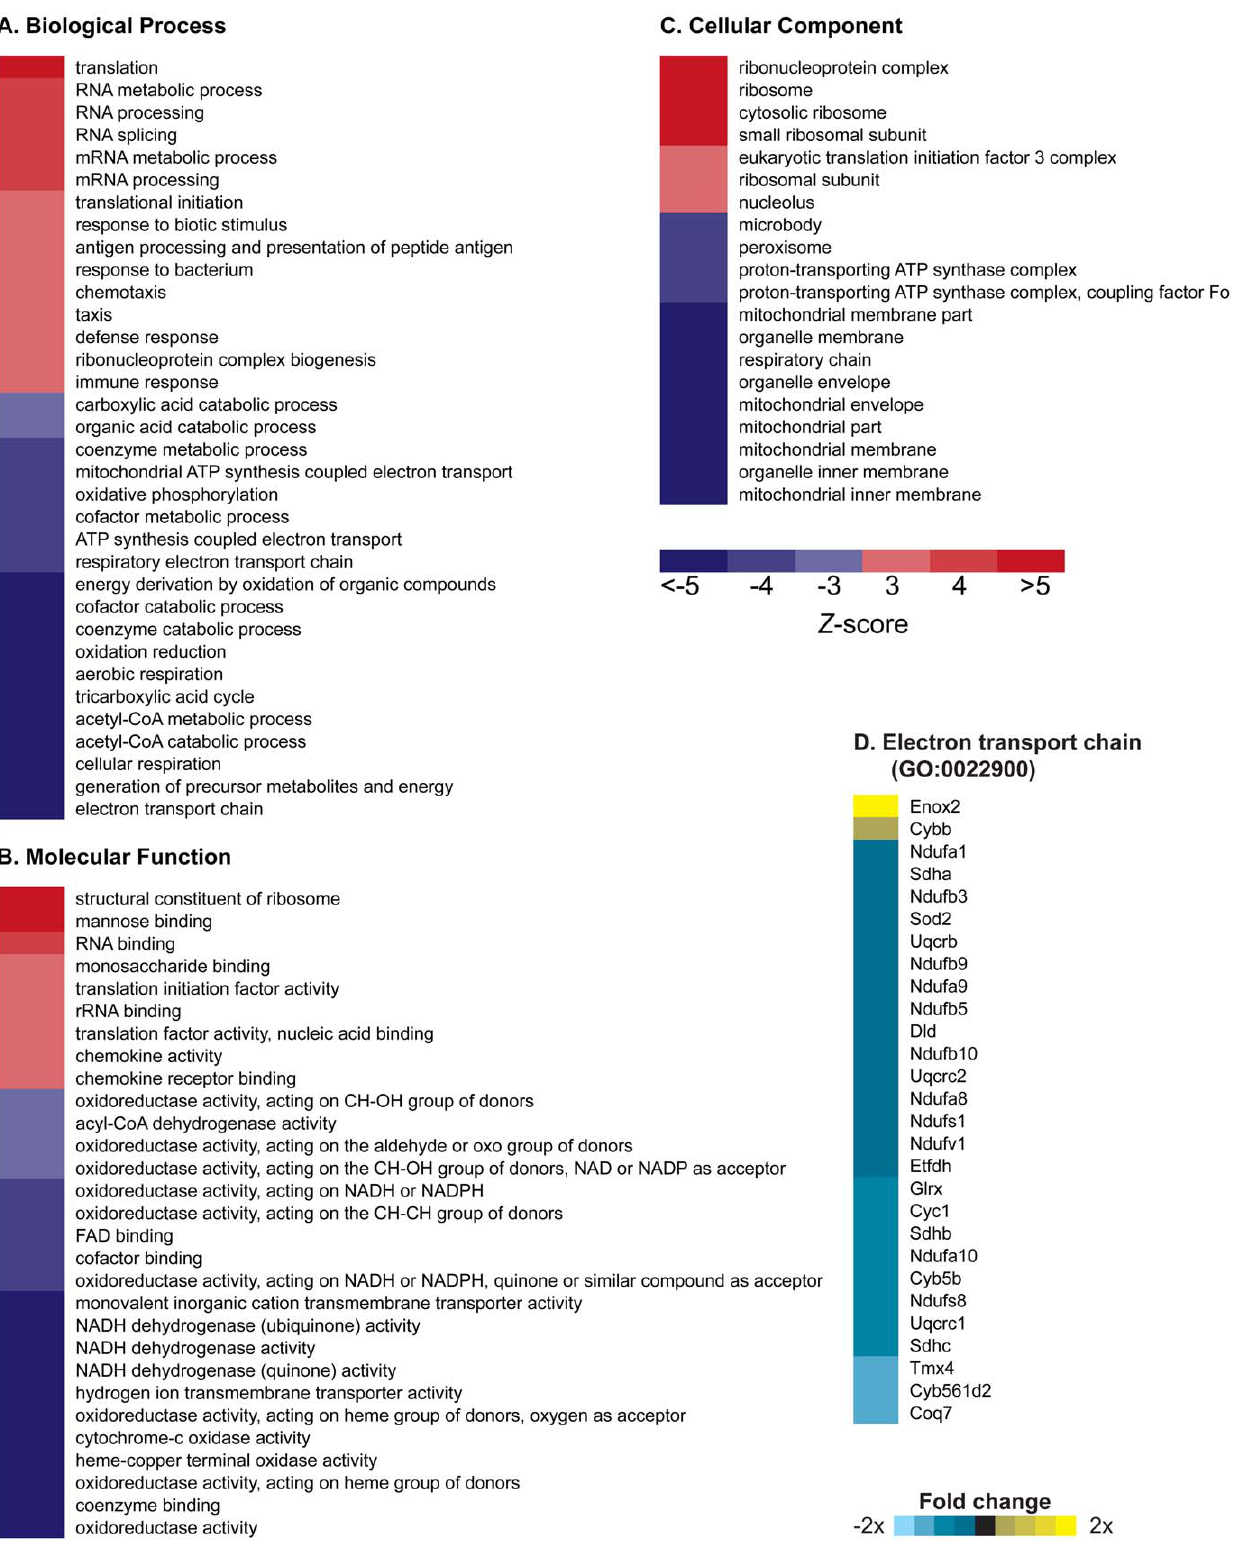
Figure 2. Parametric Analysis of Gene Set Enrichment identifies Gene Ontology (GO) terms changed in gastrocnemius muscle of 13- month old D257A mice as compared to 13-month old WT mice. (A, B, C) Terms shown are those significantly changed ( p , 0.01, FDR , 0.01). Red indicates a GO term that was induced by mtDNA mutations ( Z -score . 0); blue indicates GO terms that were suppressed by mtDNA mutations ( Z - score , 0). n=5 mice per group. (D) Genes listed within the GO term ‘‘electron transport chain’’ ( Z -score= 2 8.89; p , 0.0001) whose expression level significantly (p , 0.01) increased (yellow) or decreased (blue) in D257A mice.